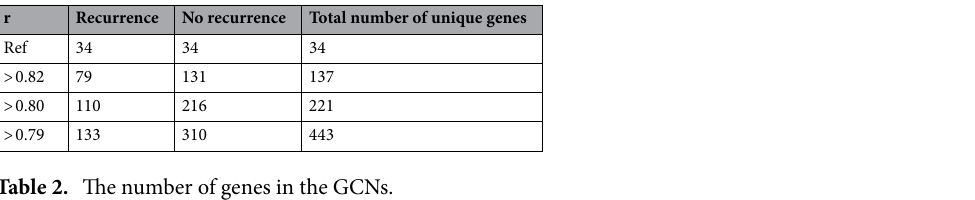
Table 2. The number of genes in the GCNs.